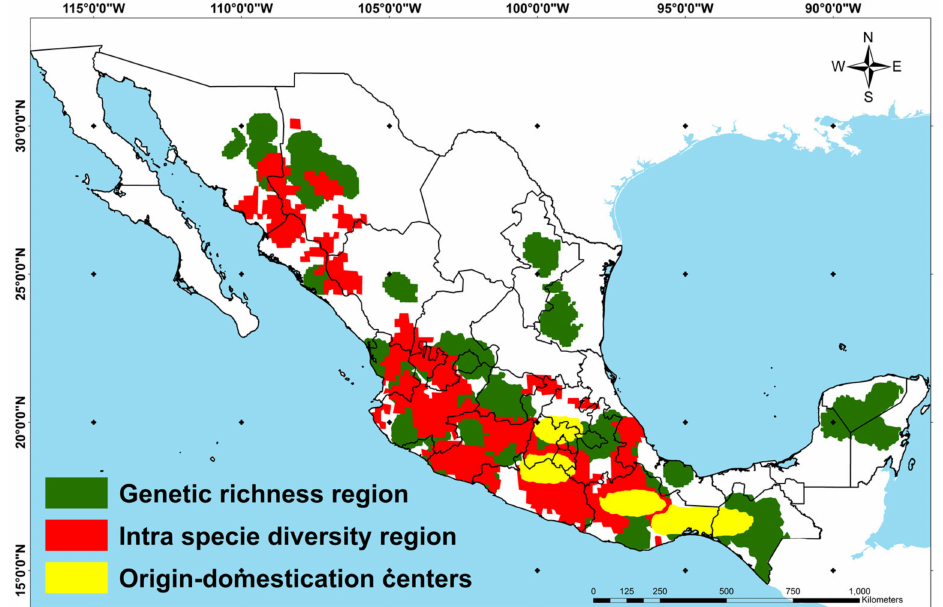
Figure 4. Spatial delimitation of the maize diversity center in Mexico obtained from the union of the maize genetic richness region, the maize intraspecific diversity region, and the centers of origin and domestication of maize established for Mexico.